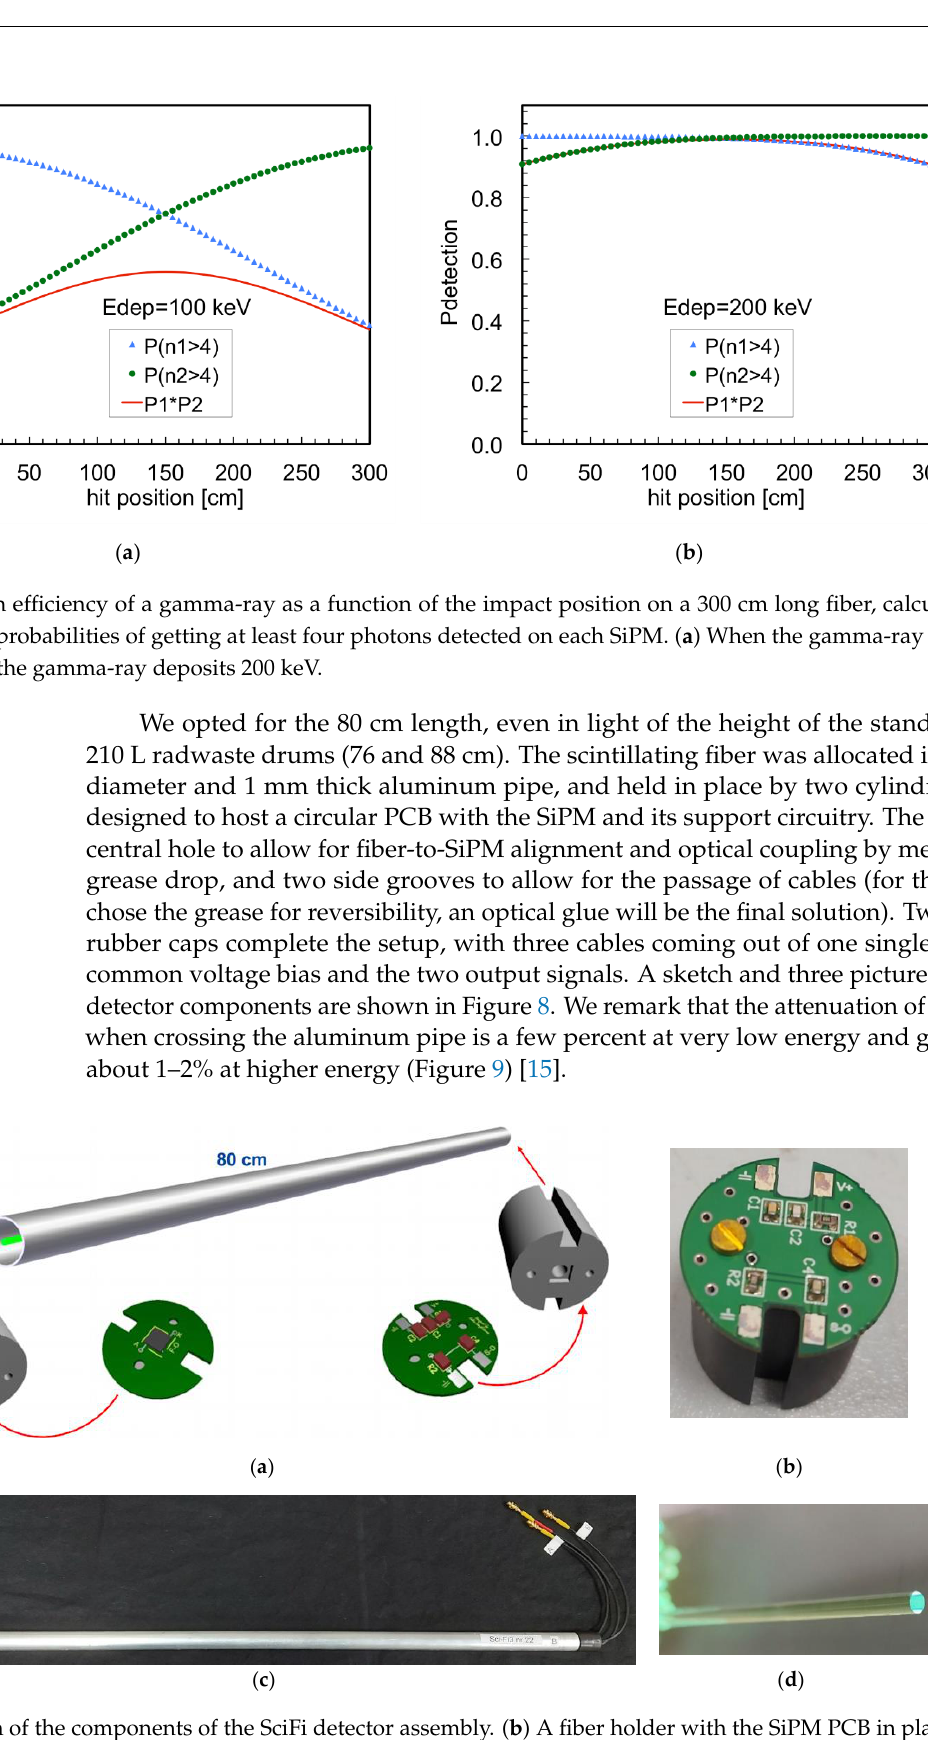
Figure 6. Detection efficiency of a gamma-ray as a function of the impact position on a 120 cm long fiber, calculated as the product of the probabilities of getting at least four photons detected on each SiPM. ( a ) When the gamma-ray deposits 100 keV . ( b ) When the gamma-ray deposits 200 keV.